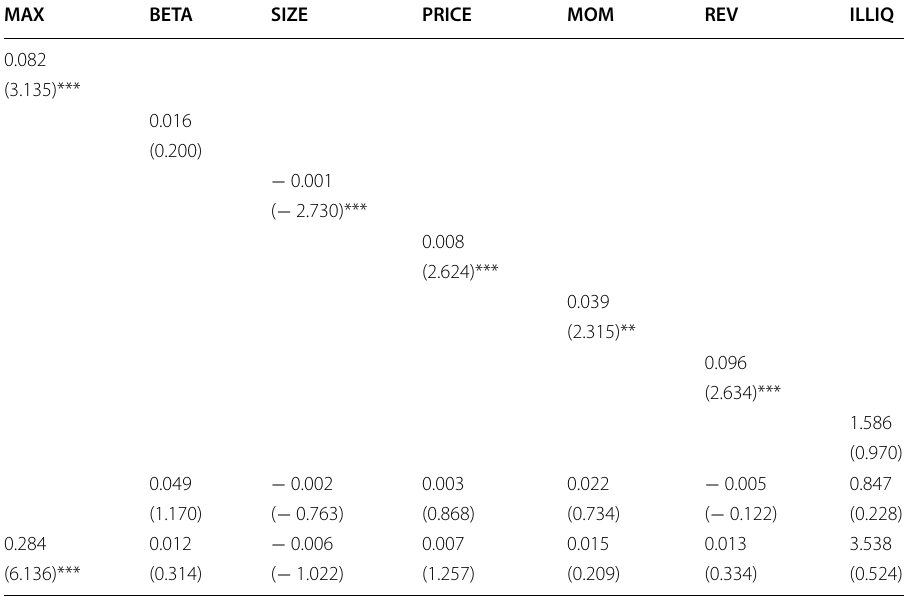
Table 8 Cross-sectional return